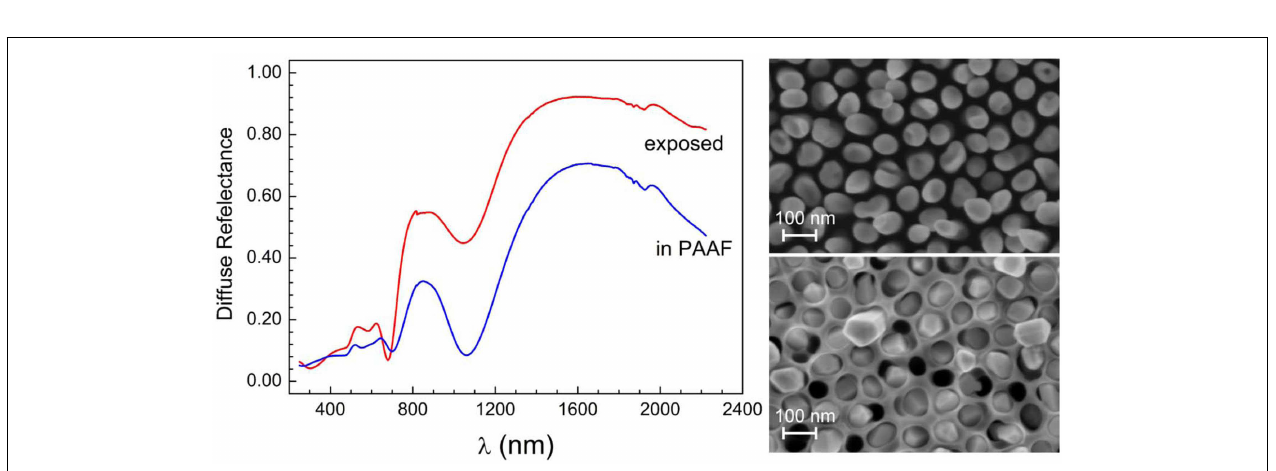
FIGURE 9 | Diffuse reflectance spectra of embedded and exposedAu-NRs of the same length (SEM micrographs are shown on the right-hand side) . “Exposed” means that the Al-oxide template has been dissolved.